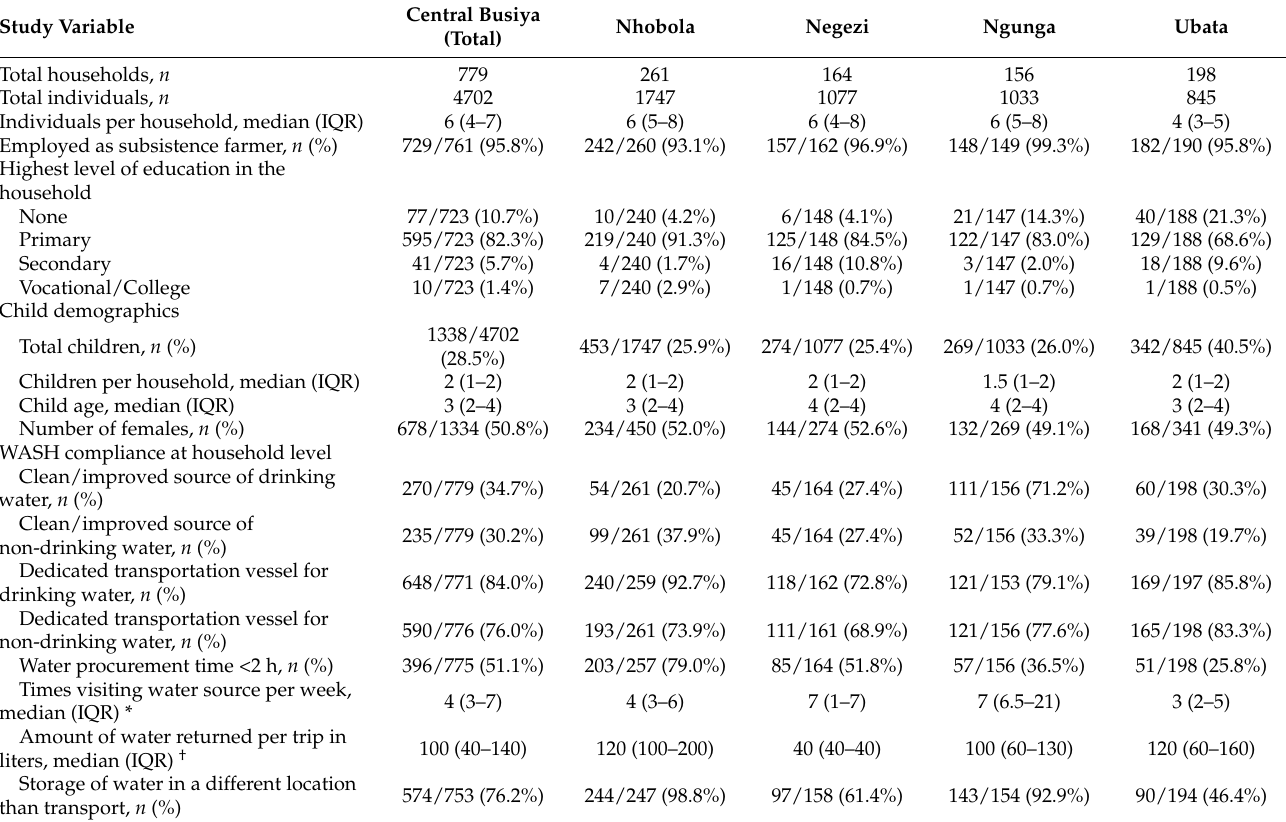
Table 1. Household demographics and water, sanitation, and hygiene (WASH)